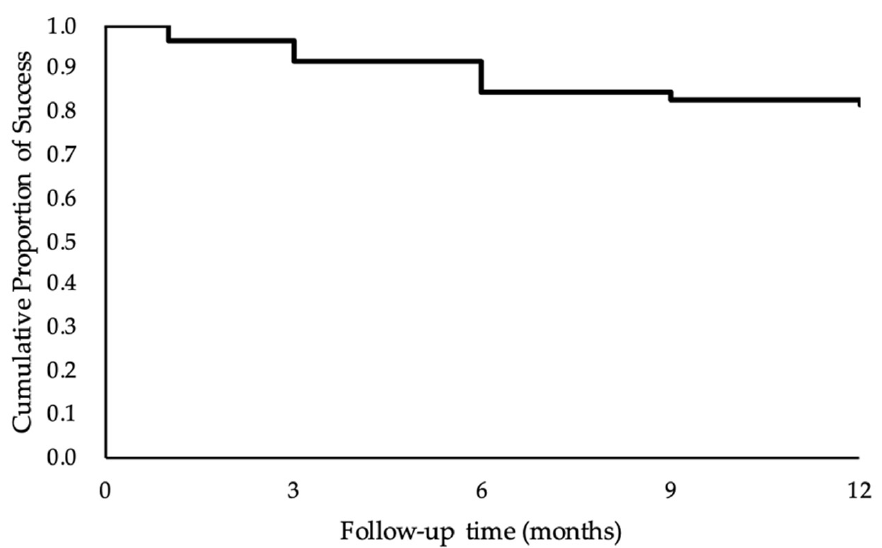
Figure 1. Kaplan–Meier curve representing the probability of success over time after MP-TSCPC treatment. The cumulative probability of success after MP-TSCPC was estimated to be 96.7% at 1 month, 91.7% at 3 months, 85.0% at 6 months, 83.3% at 9 months, and 81.7% at 12 months. Table 5. Univariate Cox proportional hazards models to investigate the significant independent predictors of treatment failure.